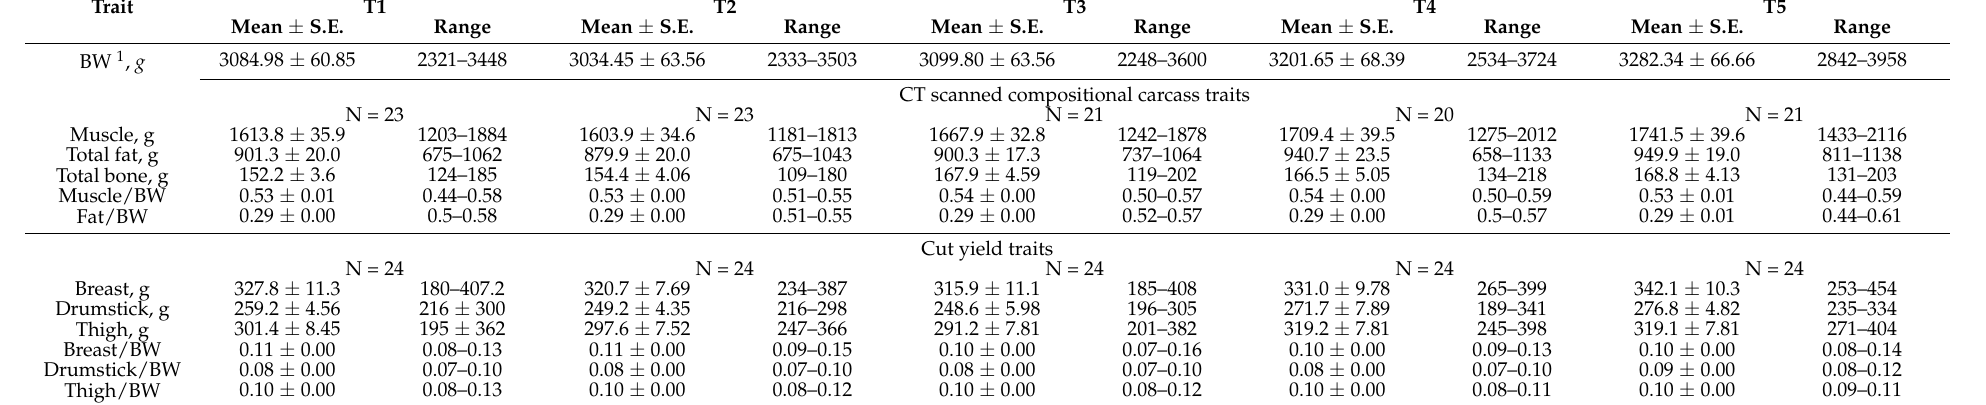
Table 2. Summary statistics of live animal, commercial, and computed tomography (CT) compositional carcass traits and cut yield for broilers fed diets including the maximum inclusion levels of 0%, 5%, 10%, 15%, and 20% of Black Soldier Fly larvae